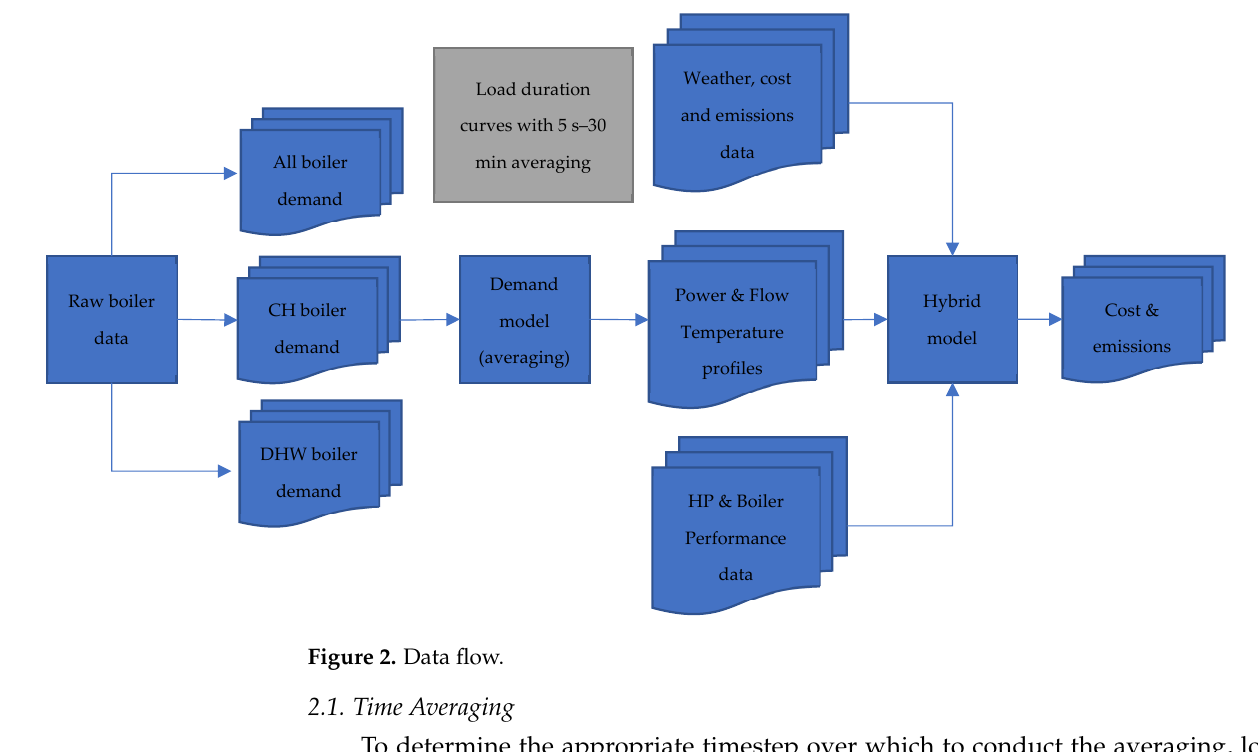
Figure 2. Data flow.